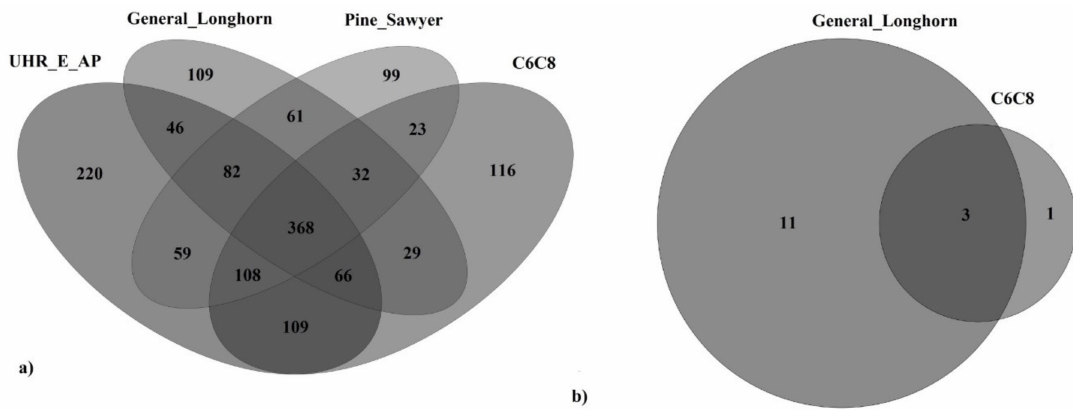
Figure 1. Venn diagram of ( a ) fungal species, shared or unique to the semiochemical type employed in the insect traps, after species subtraction and ( b ) oomycete species, shared or unique to the semiochemical type employed in insect traps, after species subtraction. All of the above were obtained by amplifying the ITS1 genic region.